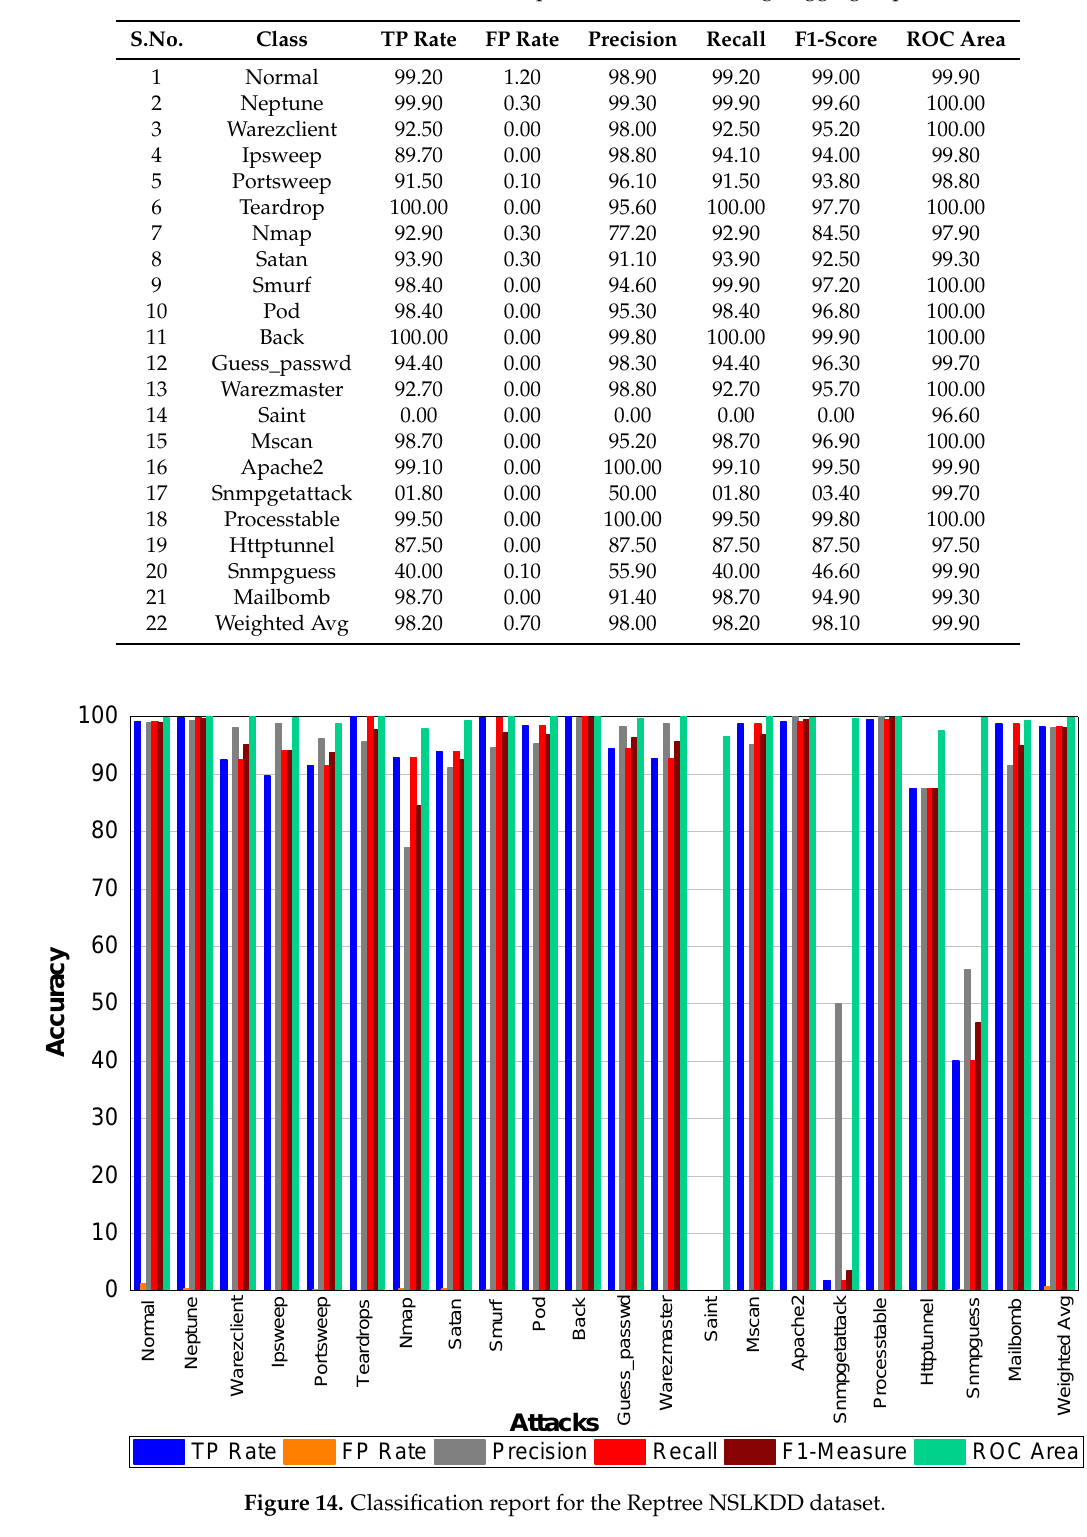
Table 44. Multiclass classification report for NSLKDD using Bagging Reptree.